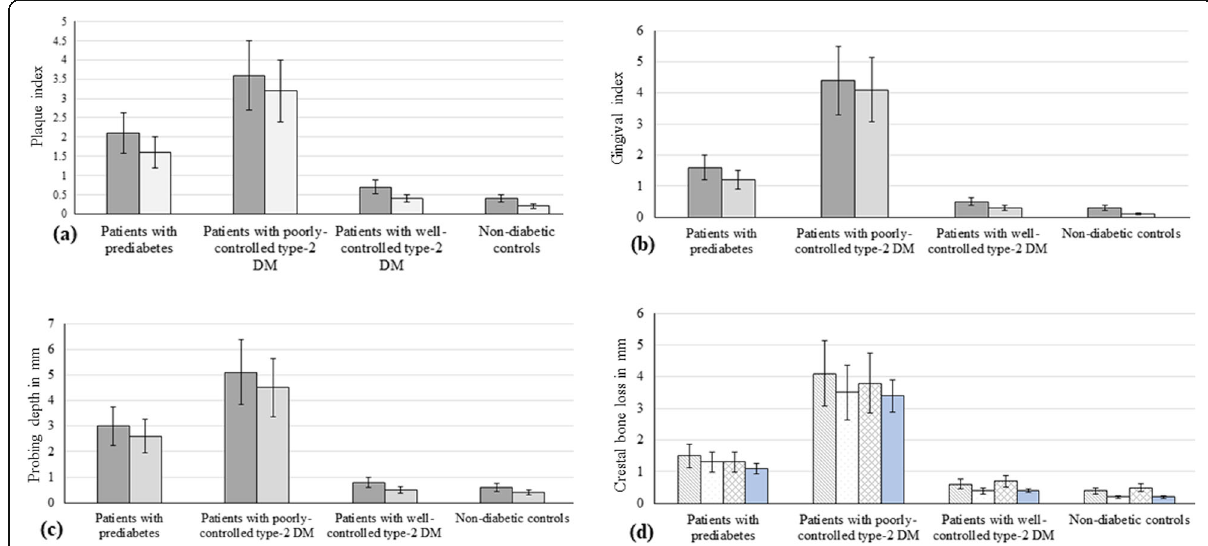
Fig. 1 a-d Clinicoradiographic parameters around implants placed in the maxilla and mandible. Dark gray bars represent implants placed in the maxilla; light gray bars represent implants placed in the mandible; striped and dotted bars represent crestal bone loss on the mesial surface of implants placed in the maxilla and mandible, respectively; cross checked and blue bars represent crestal bone loss on the distal surface of implants placed in the maxilla and mandible,